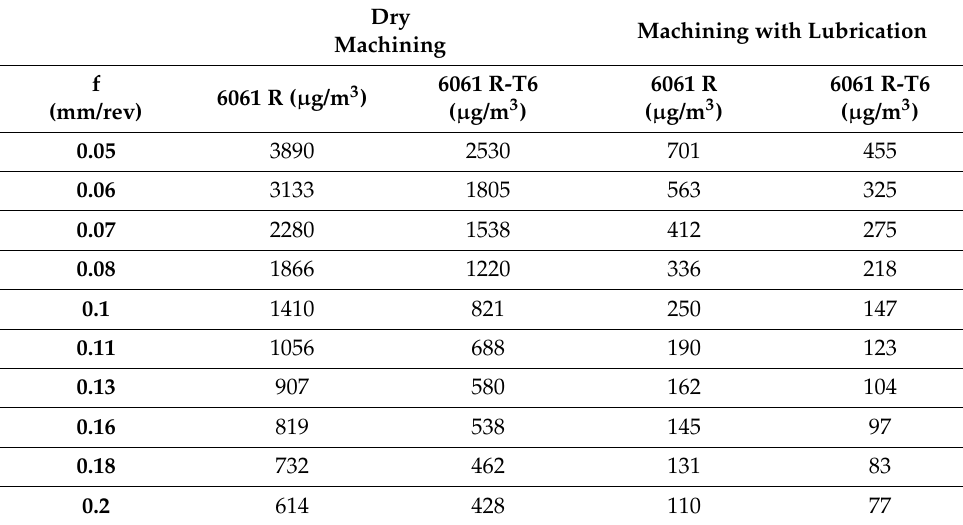
Table 8. Mass concentration of metal particles (C m